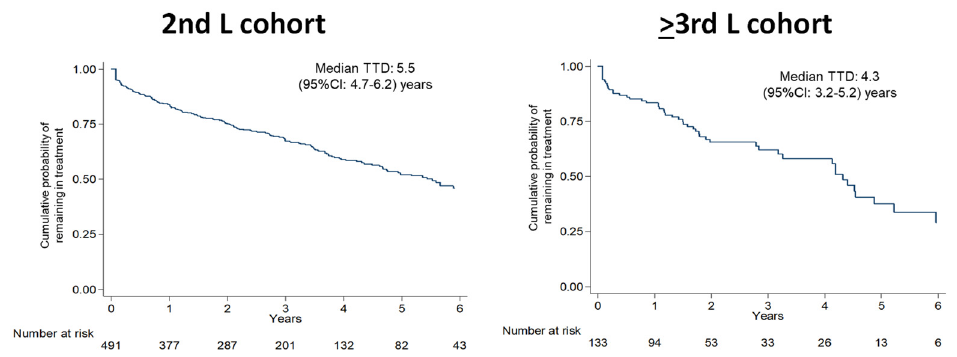
Figure 3. Time to Figure 3. Time to discontinuation.